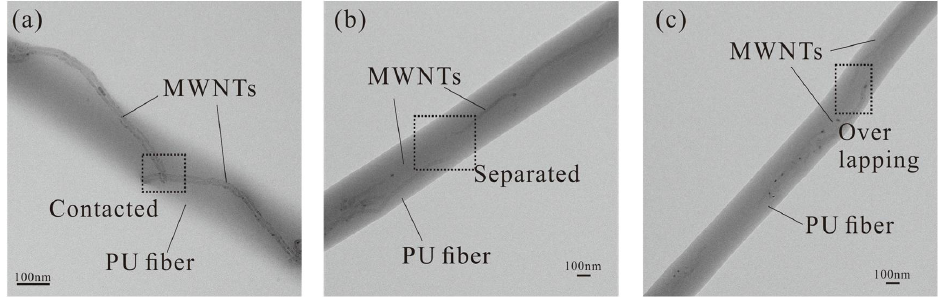
Figure 7. Transmission electron microscope (TEM) images to show positional relations between MWNTs in PU SMF: ( a ) Contacted MWNTs; ( b ) Separated MWNTs; ( c ) Overlapping MWNTs.